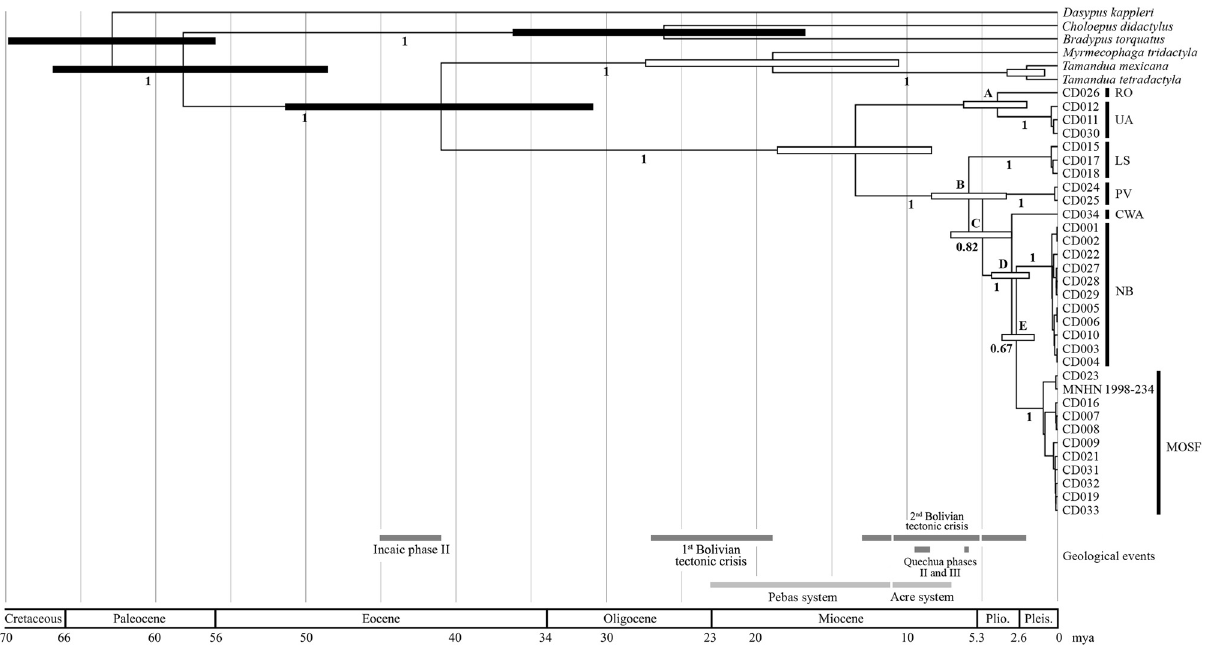
Figure 3 - Molecular timescale for Cyclopes didactylus and other xenarthran nodes inferred in this study. Node ages were obtained using a relaxed clock model under the reversible-jump based substitution model, allowing gamma rate heterogeneity and invariant sites, and a birth-death tree prior with soft fossil calibrations. Node bars indicate the 95% HPD intervals for age estimates in million years ago. Plain black and white node bars indicate constrained and unconstrained nodes, respectively. Divergence dates less than 1 mya are not represented. Letters at nodes refer to Table